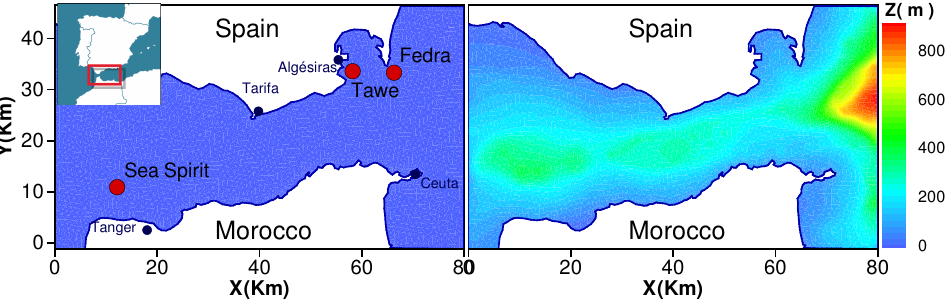
Figure 6. Location ( left ) and bathymetry ( right ) of the Strait of Gibraltar with details showing the initial location of oil spills from the Sea Spirit, Fedra, and Tawe accidents (red